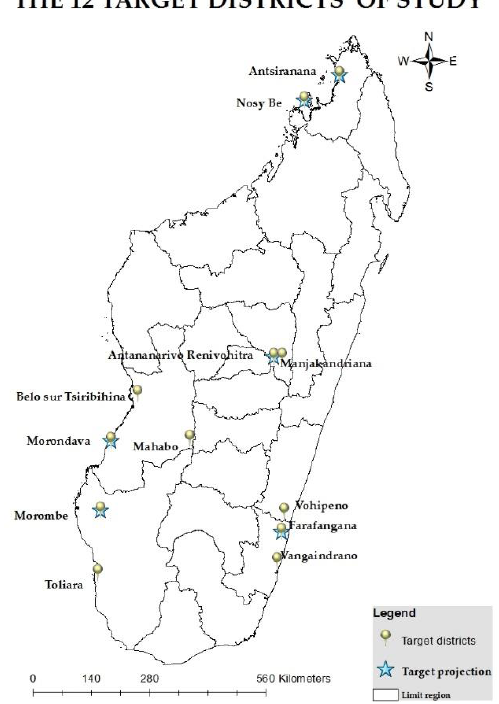
Figure 2. The target districts for the assessment of climate and health trends.